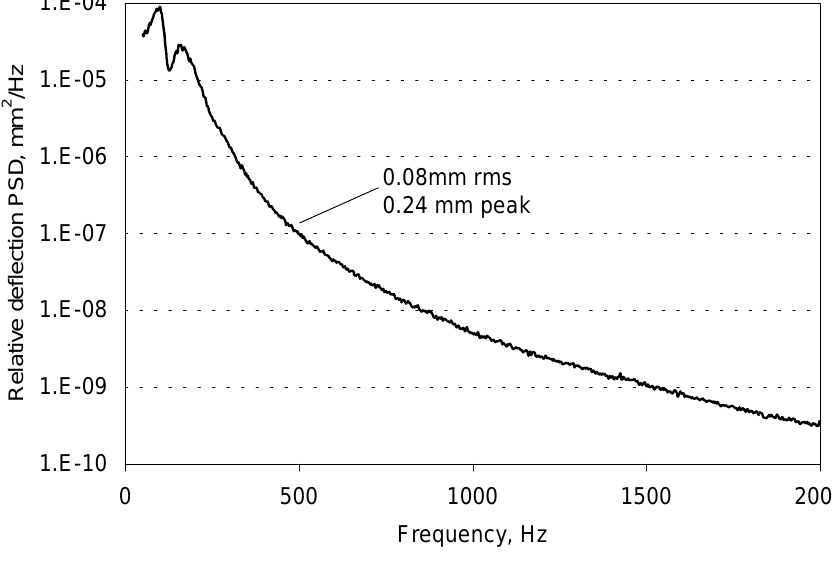
Fig. 18. Experimentally measured dynamic response of the primary vibration isolator.